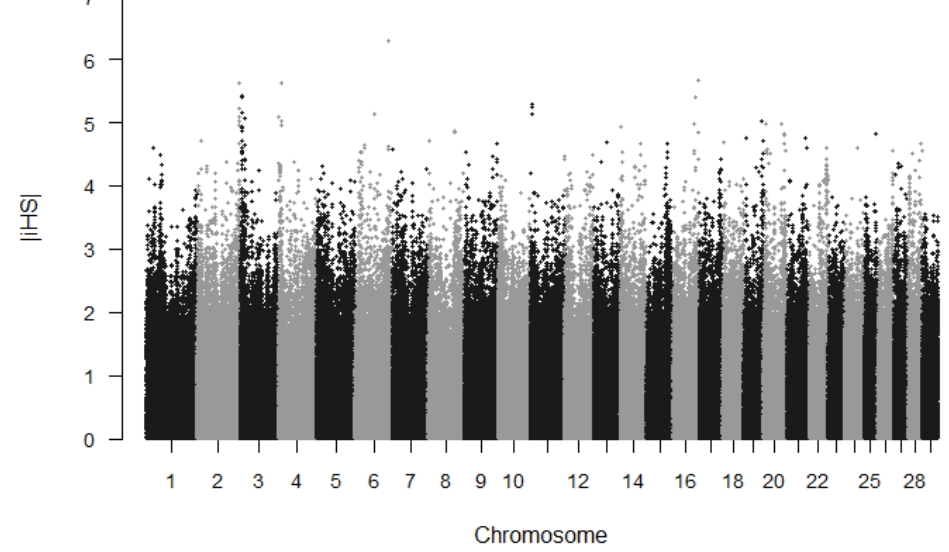
Figure 1. Genome-wide distribution of integrated haplotype score ( | iHS | ) values estimated in Chinese Wagyu cattle.